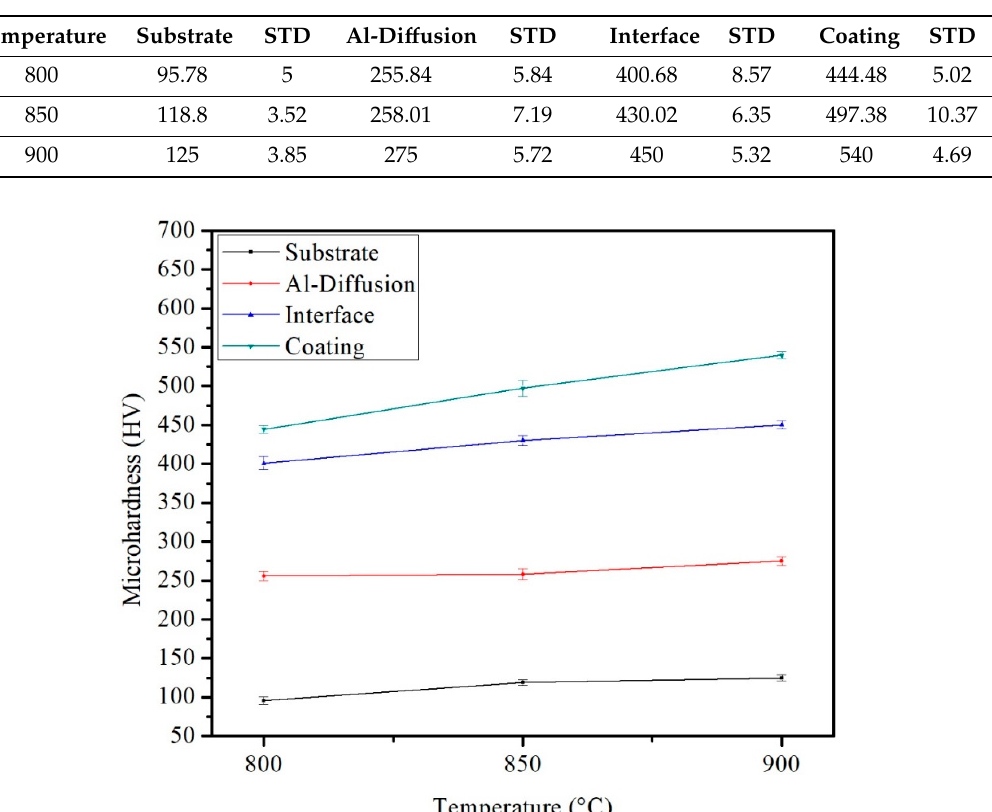
Table 1. Measurements performed from the samples obtained for each experimental condition.